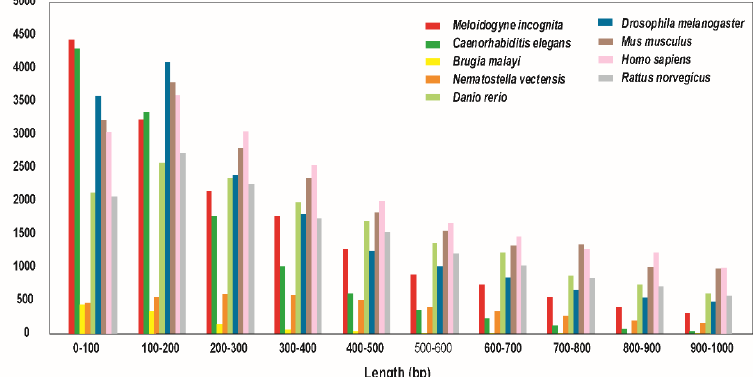
Figure 5. Comparison of 3 ′ UTR sequence length distributions among nematode species ( C. elegans , M. incognita , and B. malayi ), mammalian groups (human, mouse, and rat) and others (starlet sea anemone, fruit fly, and zebrafish). Overall, M. incognita had longer 3 ′ UTR sequences than C. elegans , except for sequences 100–200 bp in length .